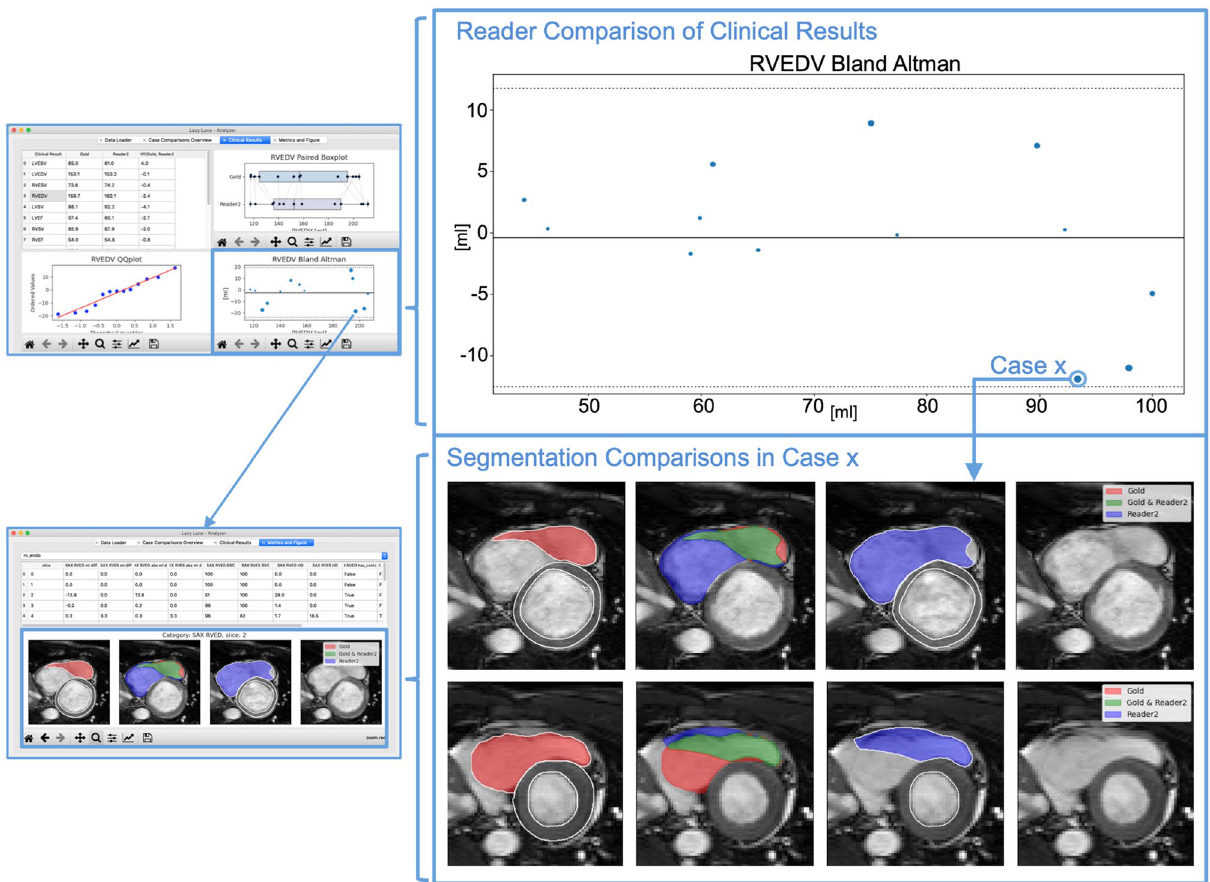
Figure 3. Tracking and Visualizing Reader Differences with Lazy Luna’s GUI. Caption: On the left, two tabs of Lazy Luna’s GUI are presented. On the right, parts of these tabs are magnified. For the top tab the RVESV Bland- Altman plot (outlined in blue) is magnified. For the bottom tab the visualization of segmentation differences is magnified. The first reader’s segmentations (subplot 1) are in red, the second reader’s are in blue (subplot 3). In the second subplot agreement is in green and areas exclusive to one reader are in that reader’s respective colour. The top tab includes a table of clinical result averages per reader next to their average differences (top left), a QQ-plot (bottom left) and paired boxplots (top right). Clicking a point in the Bland-Altman plot opened the lower tab. This tab’s table presents all metric values concerning the case’s segmentations. RV: Right